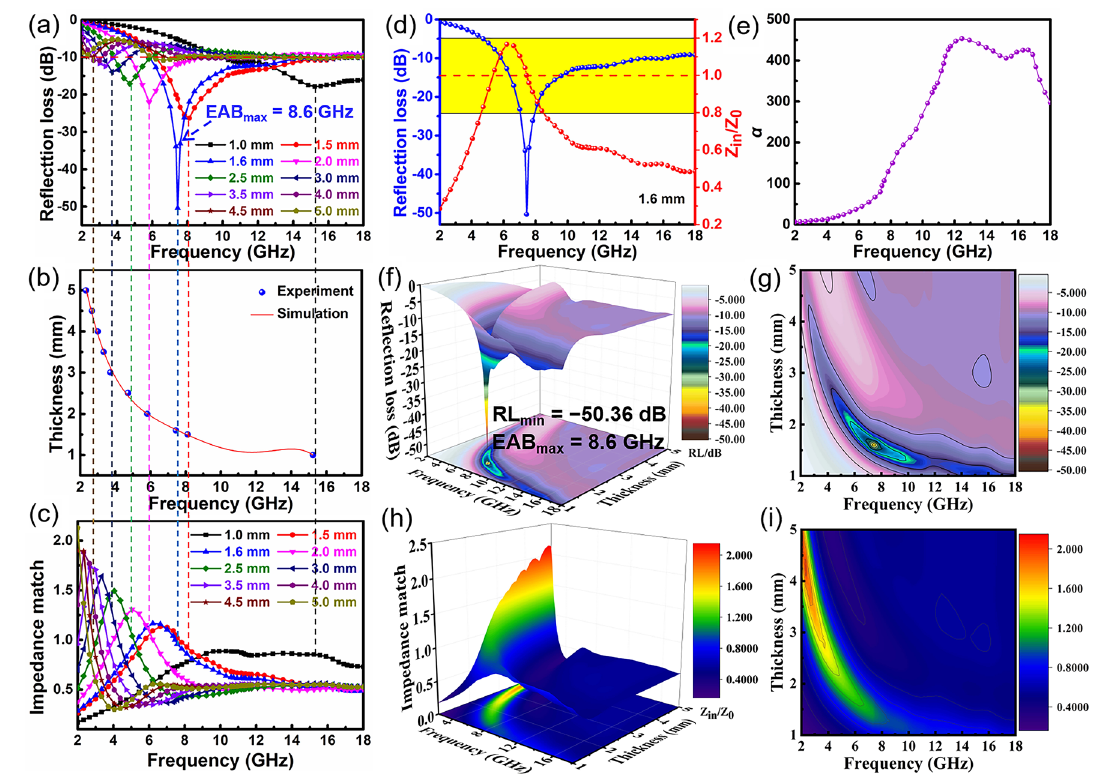
Fig. 8 EMW absorption performance of the SiC@SiO 2 NFA. a Frequency- and thickness-dependent RL values, b the relationship between the simulation thickness and peak RL at typical frequencies, c the frequency- and thickness-dependent impedance matching (Z), d the relationship between RL min and Z at a thickness of 1.6 mm, e the attenuation constant α, f 3D and g 2D representations, and h 3D and i 2D plots of Z for the